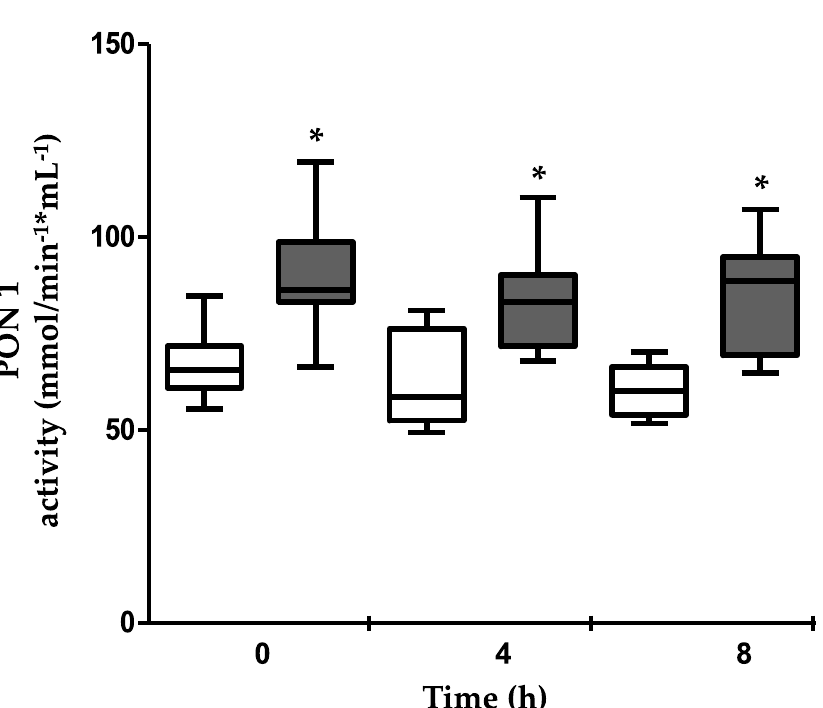
Figure 1. Effect of microencapsulated pomegranate (MiPo) on paraoxonase–1 (PON1) activity in the serum of acute coronary syndrome (ACS) women. PON1 activity was determined at the basal conditions (white boxes) and after 30 d of supplementation with MiPo (gray boxes). The measurements were taken at fasting and at 4 and 8 h after the lipid load test. The median is represented by the horizontal line and boxes represent the interquartile interval. * Wilcoxon’s test p ≤ 0.01, between pre- and post-supplementation.